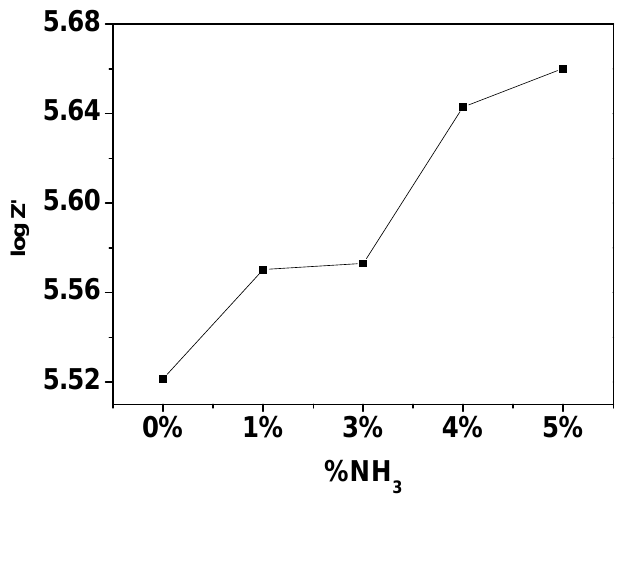
ClO + CdS based TEMPOS 4 4